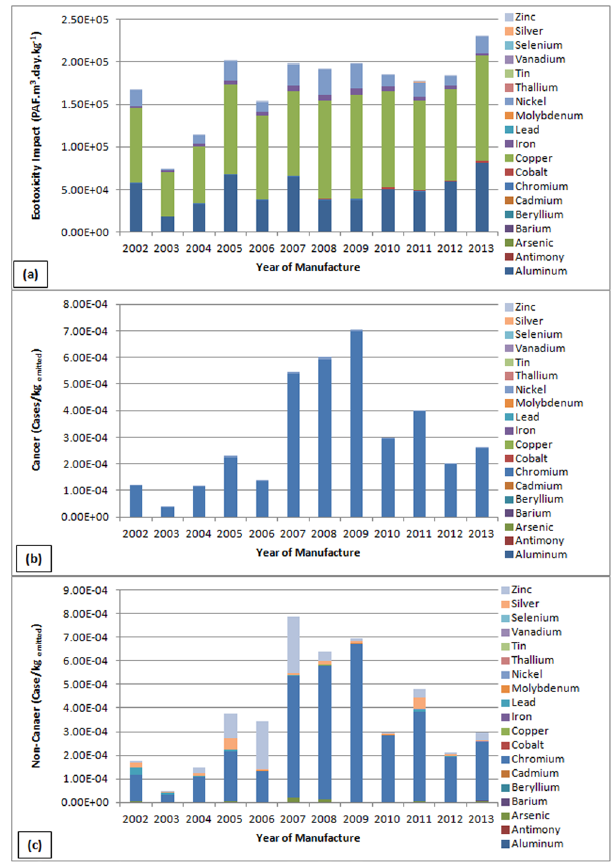
Figure 1. Results of USEtox chemical life cycle assessment of eco-toxicological ( a ), human carcinogenic ( b ), and non- carcinogenic ( c ) impacts of metals in waste mobile phones.